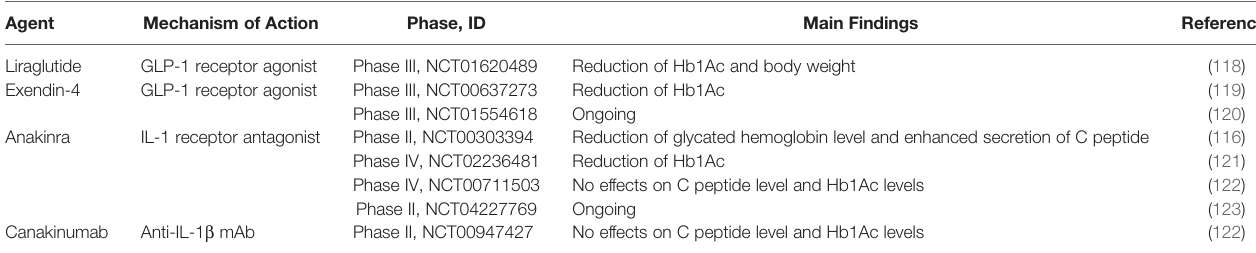
TABLE 2 | Summary of major clinical trials for anti-in fl ammatory therapies on T2D. Agent